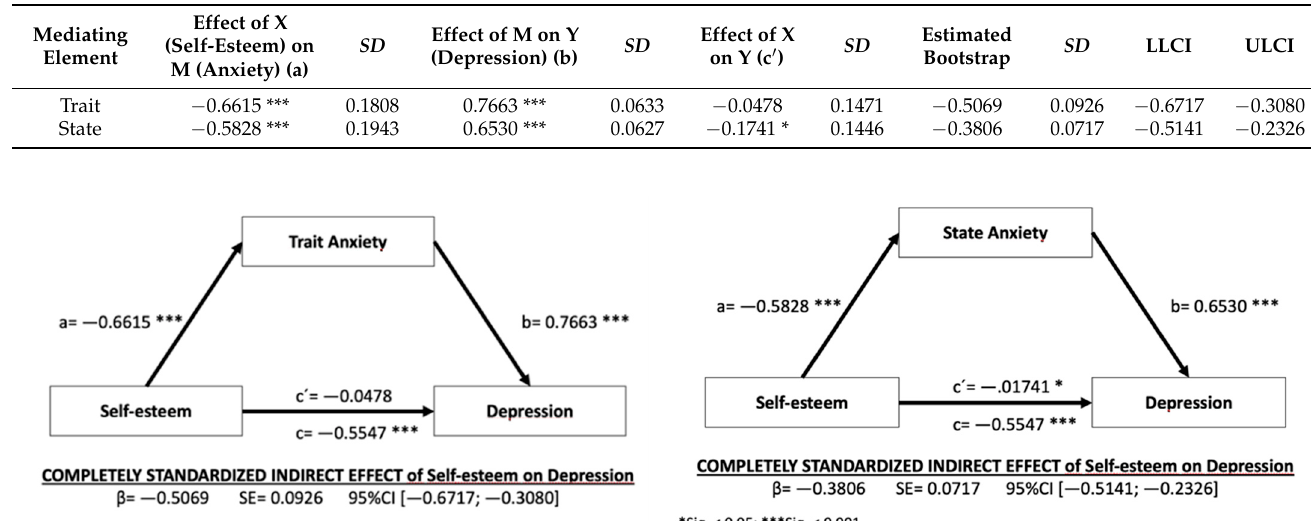
Table 8. Results of the mediation of self-esteem on depression through anxiety. *** p < 0.001